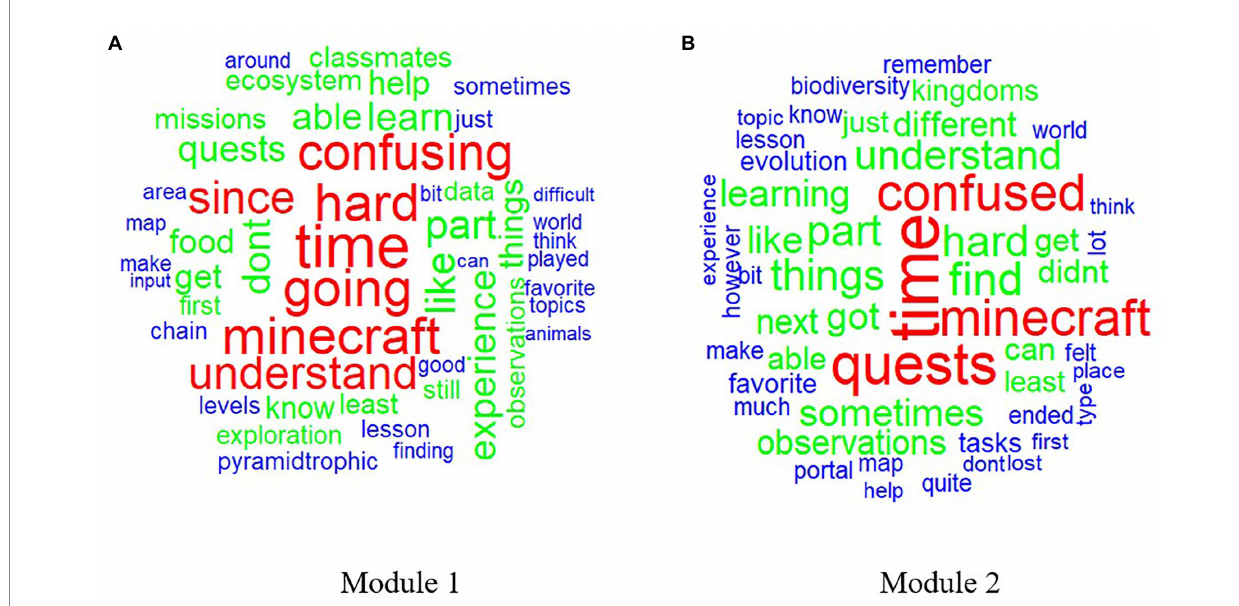
FIGURE 10 Frequencies of Dominant Words on the Least Favorite Attributes. (A) Module 1, (B) Module